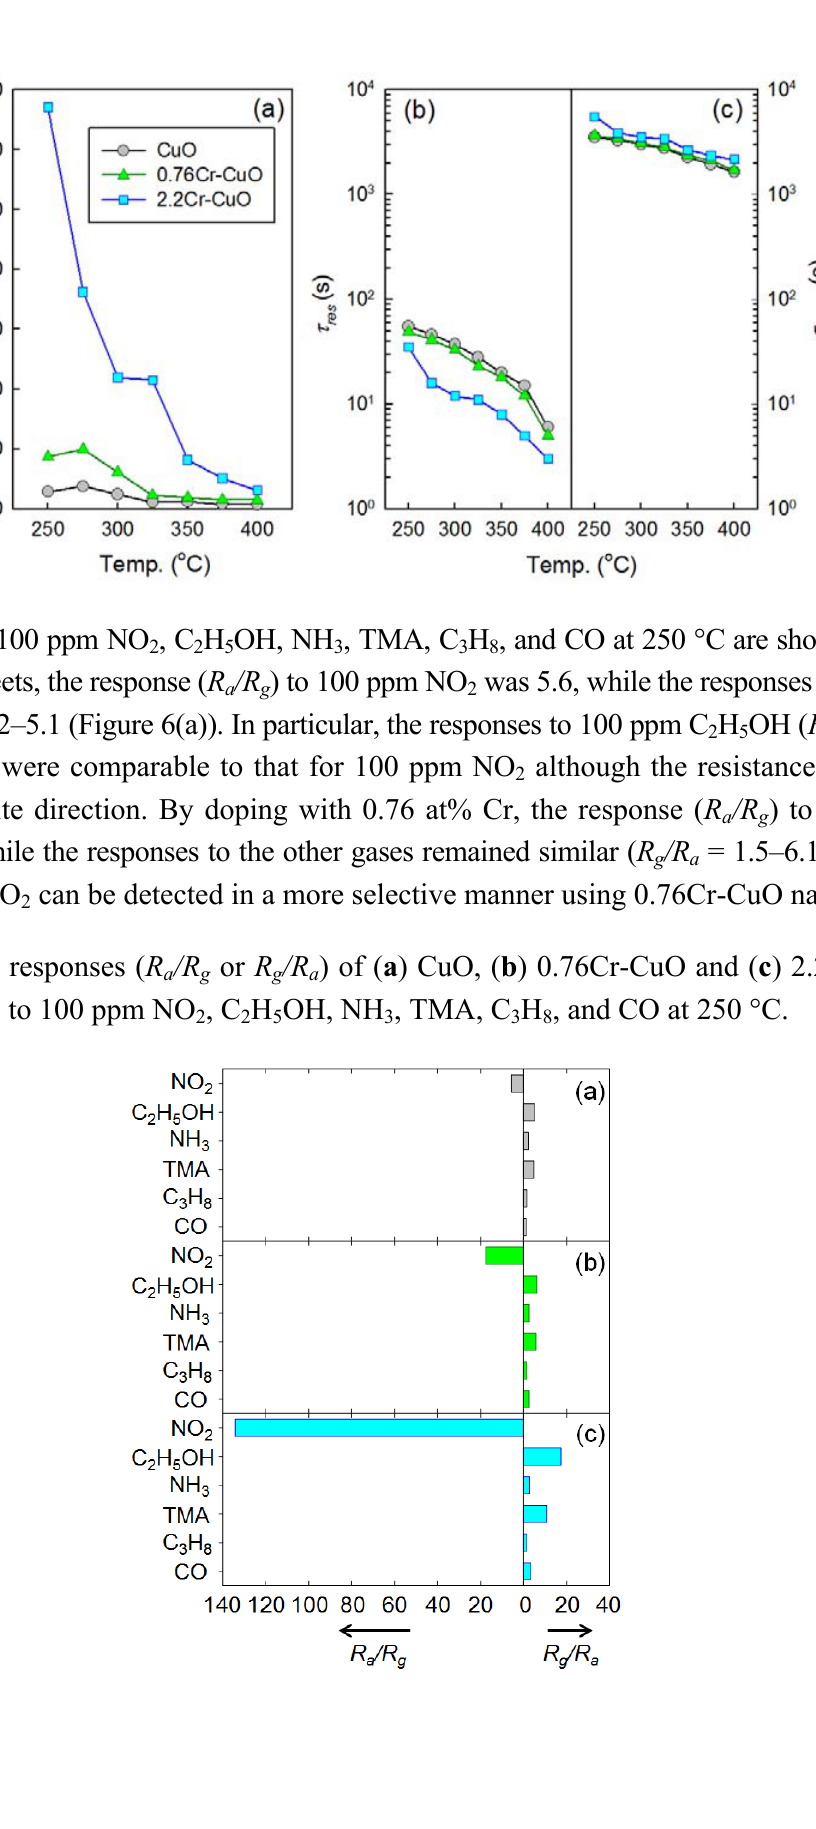
/R ), ( b ) 90% response time ( τ a g